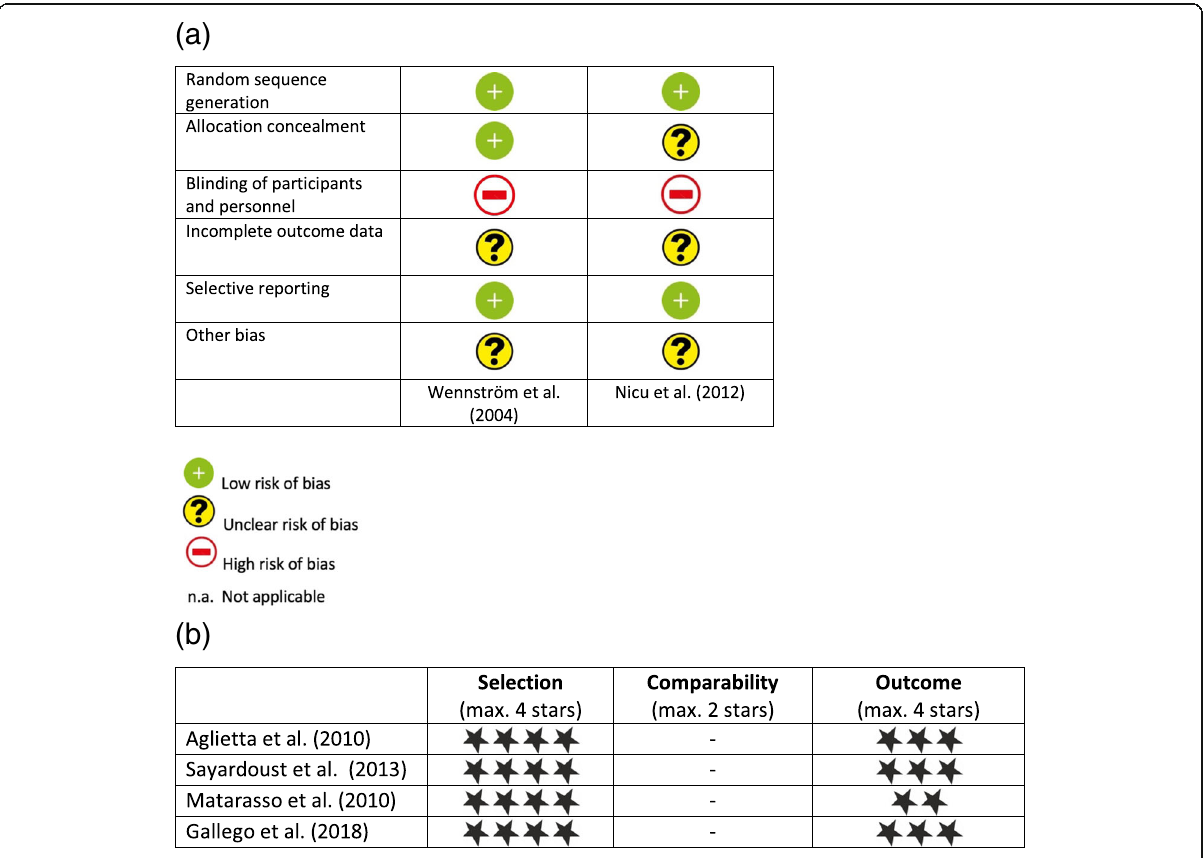
Fig. 2 a Presentation of risk of bias evaluation for included RCTs according to the Cochrane Collaboration ’ s tool. b Presentation of risk of bias evaluation for included non-RCTs according to the Newcastle-Ottawa assessment